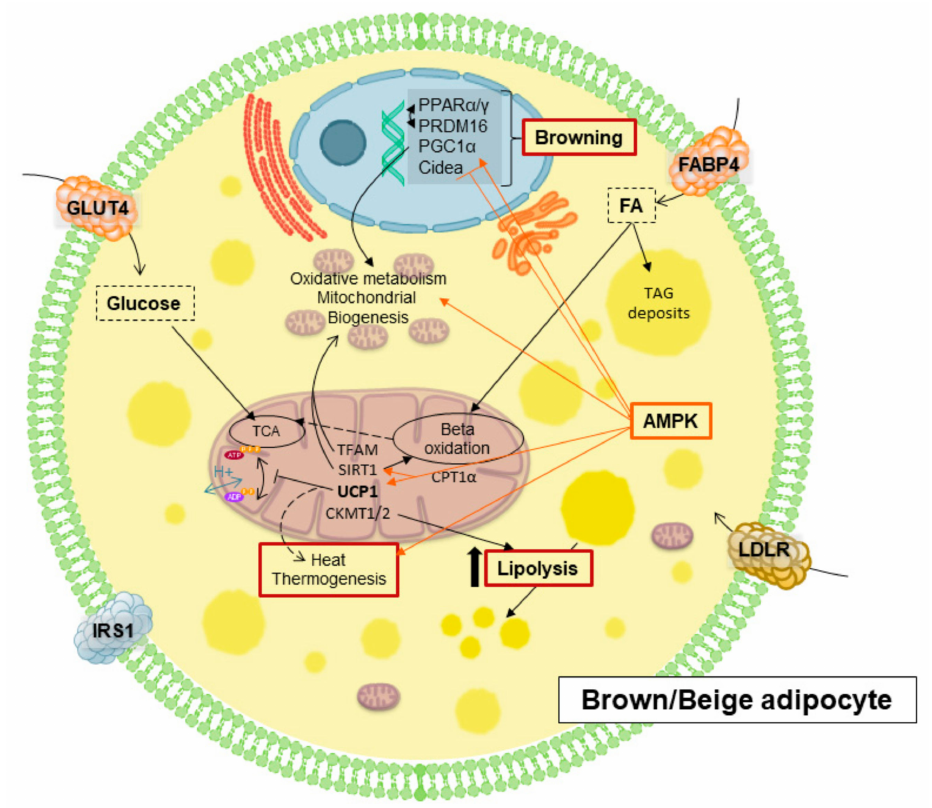
Figure 3. Main mediators implicated of browning and thermogenesis in brown/beige